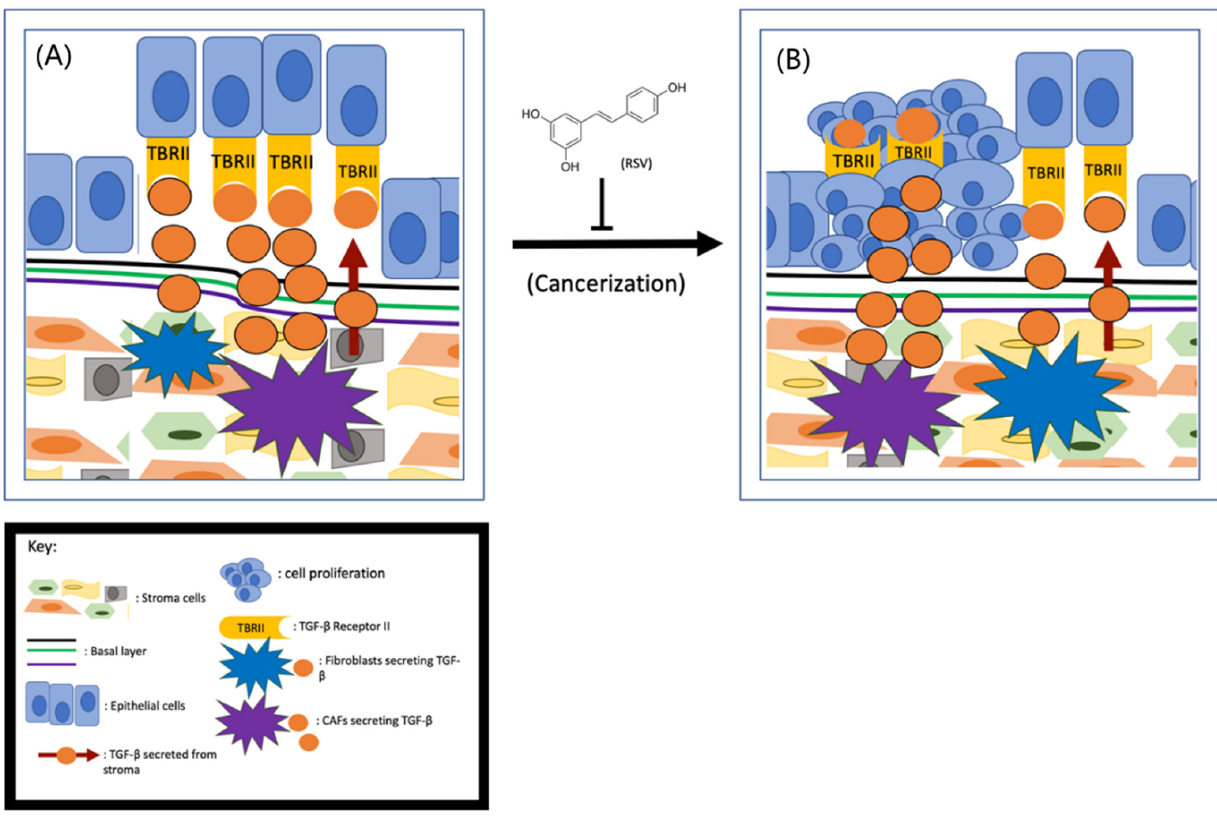
Figure 1. RSV inhibits prostate cancer initiation ( A ) CAFs- secreted TGF- β interacts with its receptors TBRII on prostate cells drives tumor initiation ( B ) and RSV is capable of inhibiting this